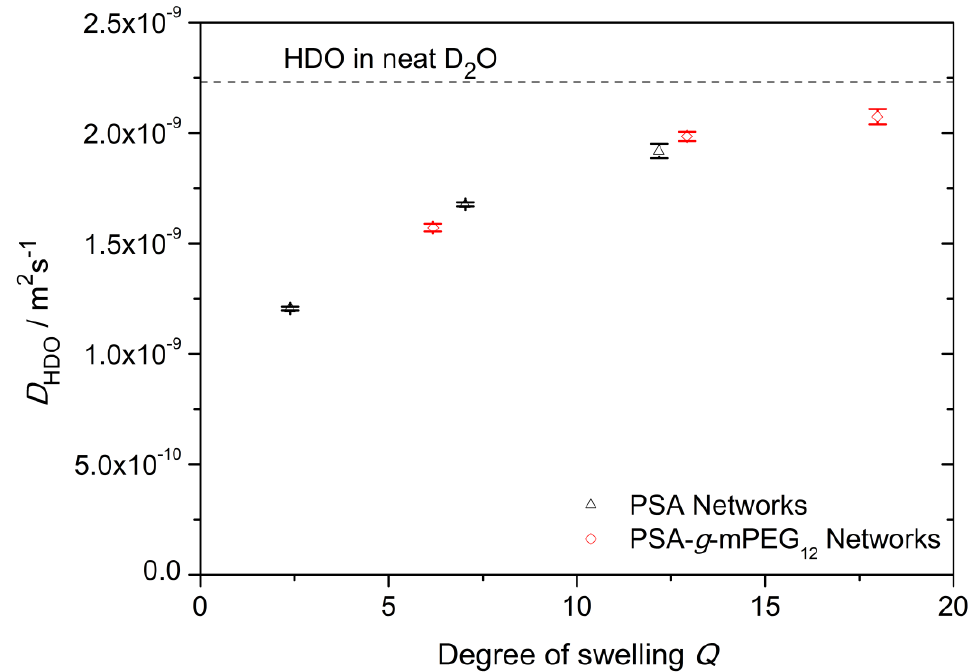
Figure 9. Dependence of the diffusion coefficient of water molecule ( D HDO ) on the degree of swelling ( Q ) in PSA and PSA- g -mPEG 12 networks at T = 30 °C. The dashed line represents the diffusion coefficient of HDO in neat D 2 O of D HDO = 2.23·10 −9 m 2 ·s −1 .